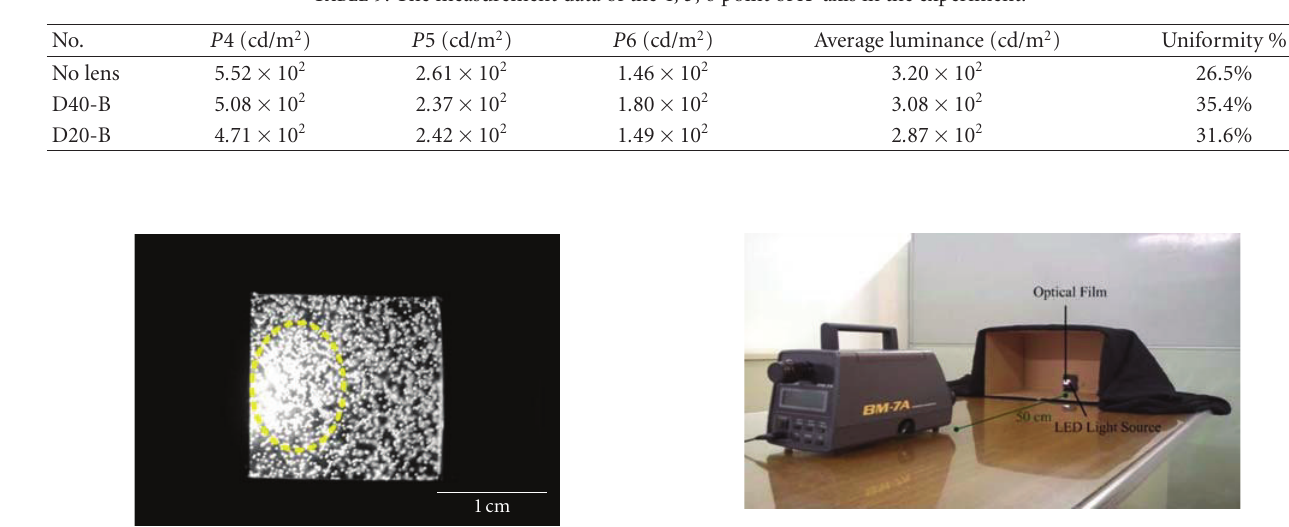
Table 9: The measurement data of the 4, 5, 6 point of X -axis in the experiment.